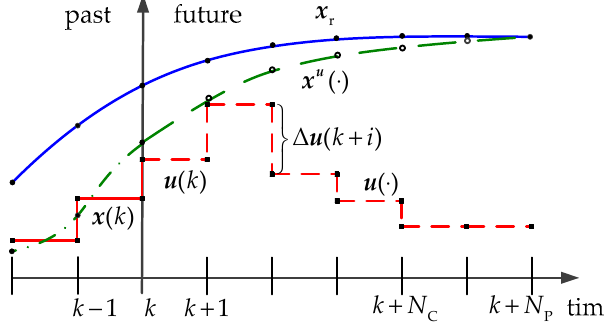
Figure 1. Control process of the model predictive control (MPC) algorithm.